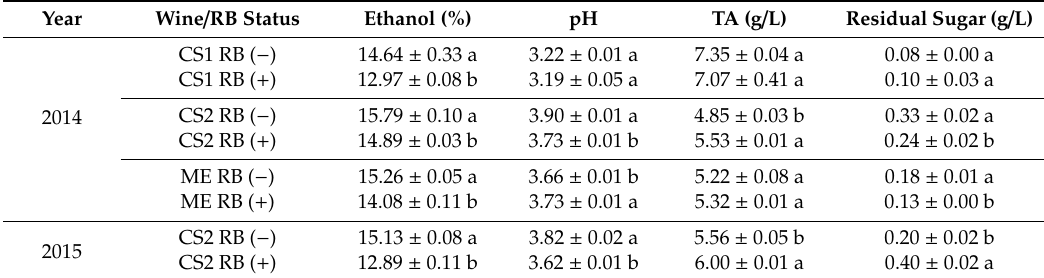
Table 2. Basic chemical composition of RB ( − ) and RB ( + ) wine in 2014 and